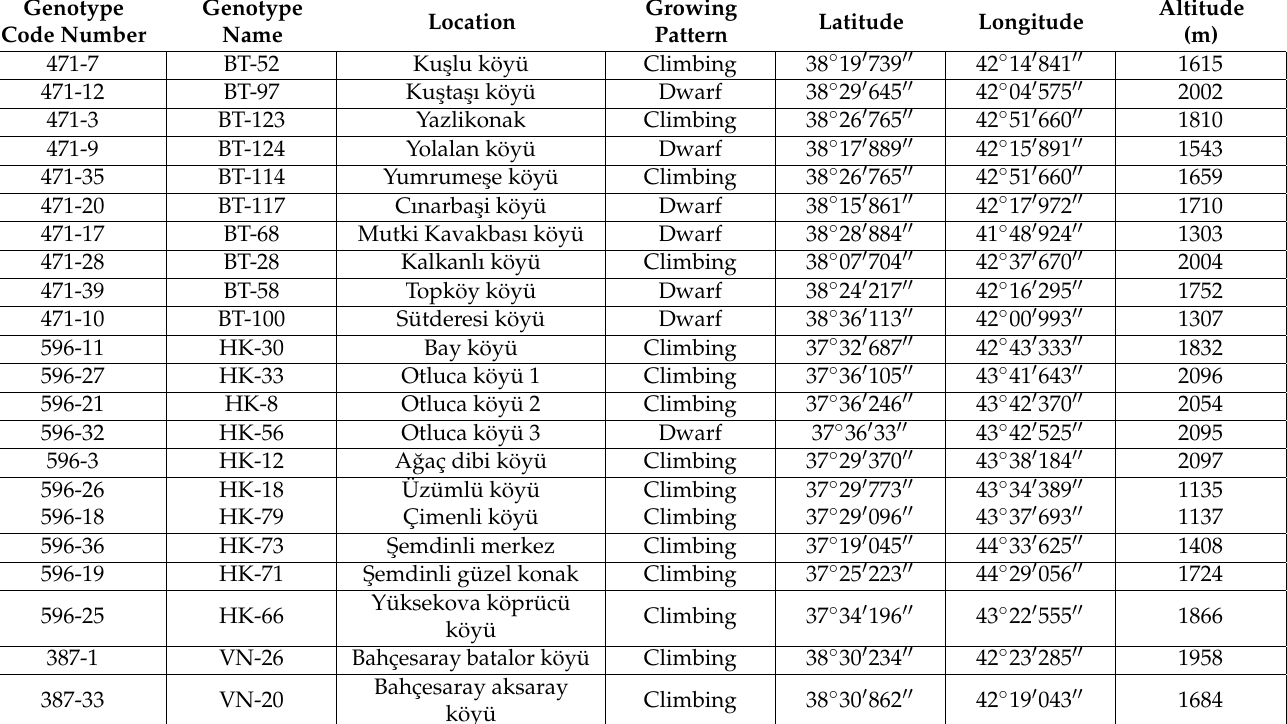
Table 1. Genotype code numbers, names, locations, growing patterns, latitude, longitude, and altitude of the common bean used as material in the